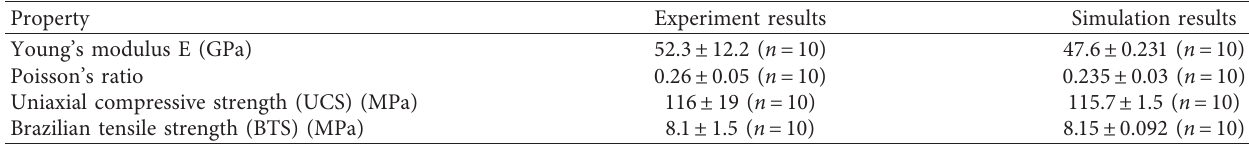
Table 2: Rock properties from experiments and simulations [31].